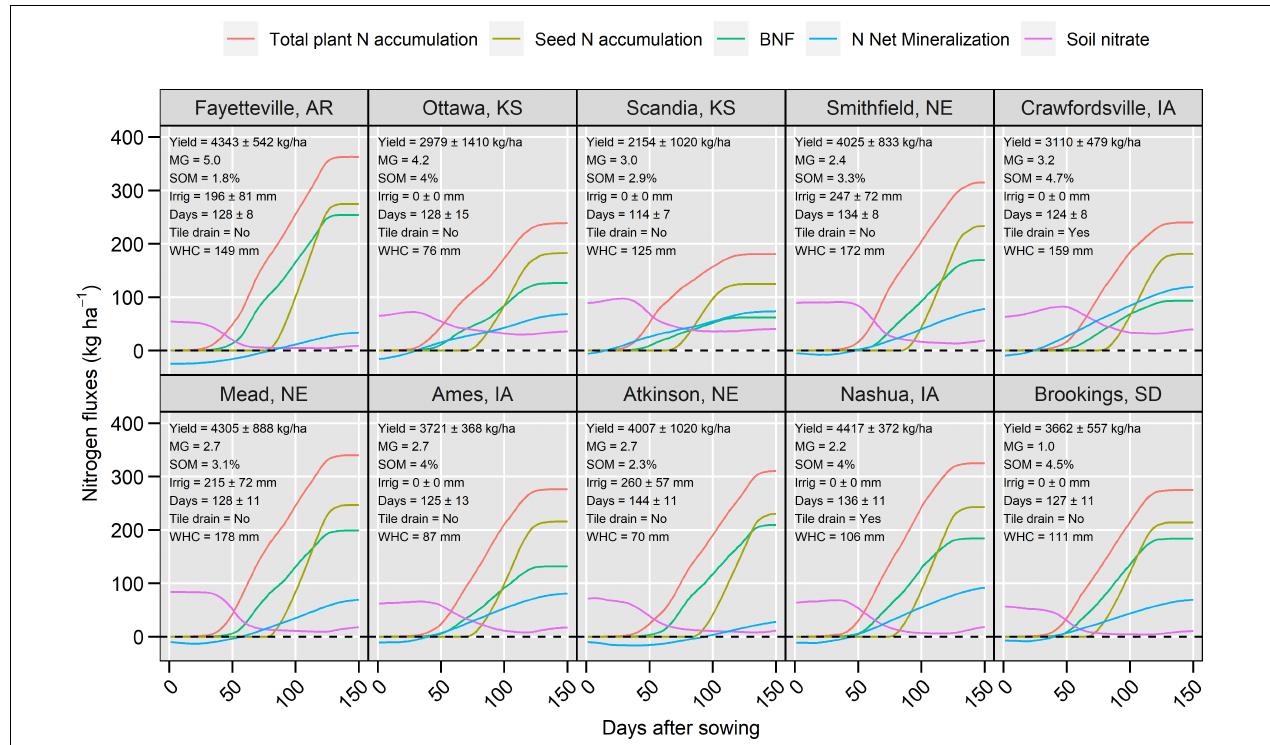
FIGURE 2 | Soil-plant N dynamics including plant and seed N accumulation, biological N fixation (BNF), soil N net mineralization and soil nitrate (0–120 cm) for all locations. The values are averages over 25-year simulations. Inset top-left panels indicate soybean 25-year average seed yield (Yield), maturity group (MG), soil organic matter (SOM, 0–30 cm), irrigation applied during the crop season (Irrig), number of days to physiological maturity (Days), existence of subsurface tile drainage (Tile drain) and soil water holding capacity to 120 cm (WHC). The N balance is illustrated in Supplementary Figure 2 . The N 2 O emissions fluxes are illustrated in Supplementary Figure 4